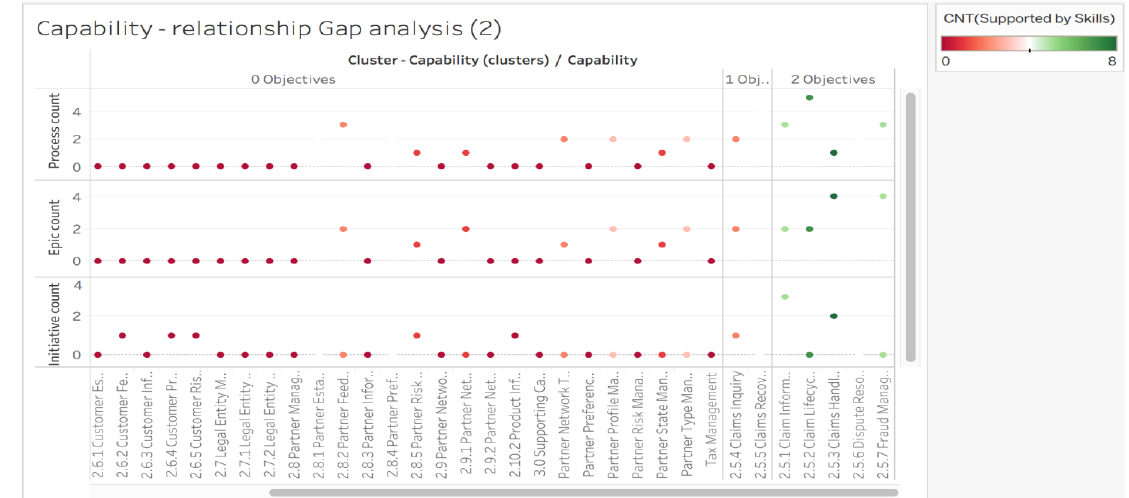
Figure 11. Capability relationship gap analysis